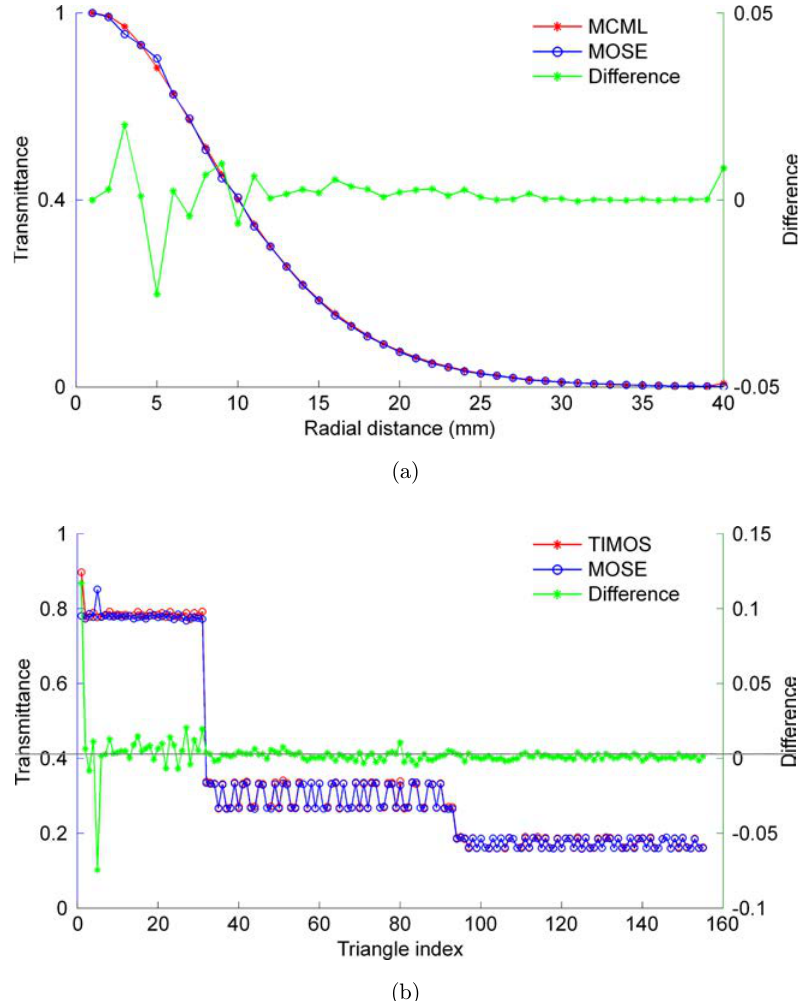
Fig. 4. Comparisons of the transmittance between the MCML, TIMOS, and MOSE in case of multilayered phantom. (a) Com- parison between the MCML and MOSE at di®erent radial distance. (b) Comparison between the TIMOS and MOSE at di®erent